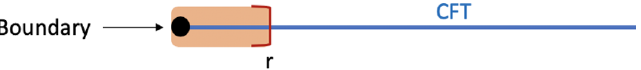
Figure 24 . For a CFT with a boundary we define entropic g function at scale r by computing the von Neumann entropy of the shaded region which includes the